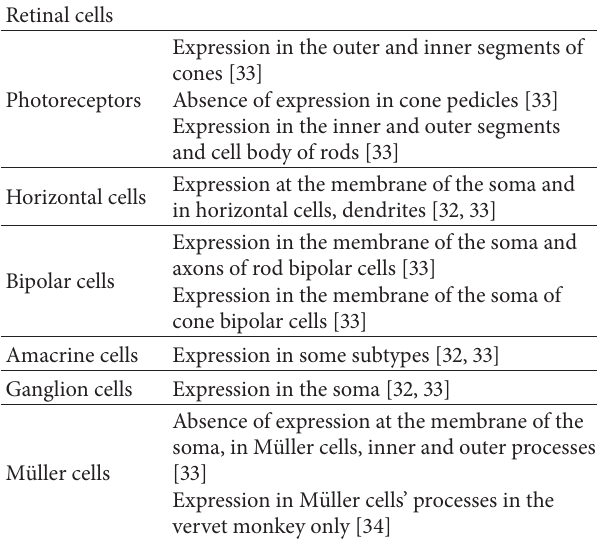
Table 2: Cannabinoid receptor type 1 protein distribution in the adult retina of various species.